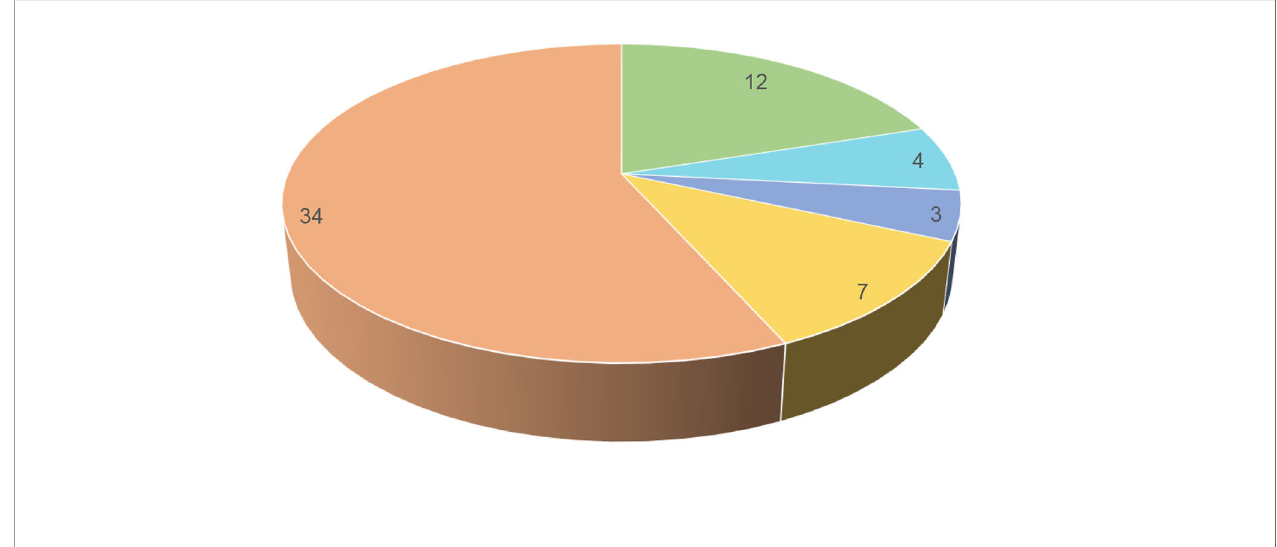
FIGURE 2 | Newborn screening for SCID in the world (n =